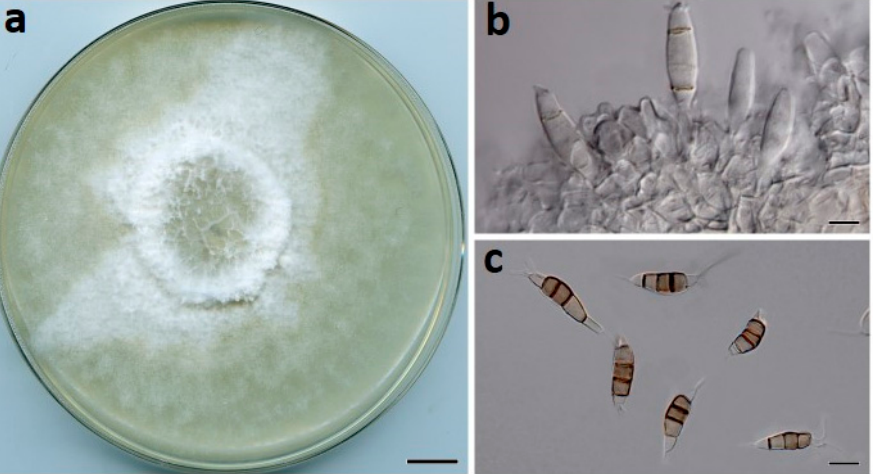
Figure 5. Neopestalotiopsis olumideae (BRIP 72273a). ( a ) Two-week-old colony on PDA, ( b ) conidiogenous cells, and ( c ) conidia. Scale bars: a = 1 cm; b–c = 10 µm. Culture characteristics : Colonies on PDA after 7 d at 25 ◦ C reach 60 mm diam., with MycoBank: MB840918. whitish cottony aerial mycelium; reverse cream to buff.